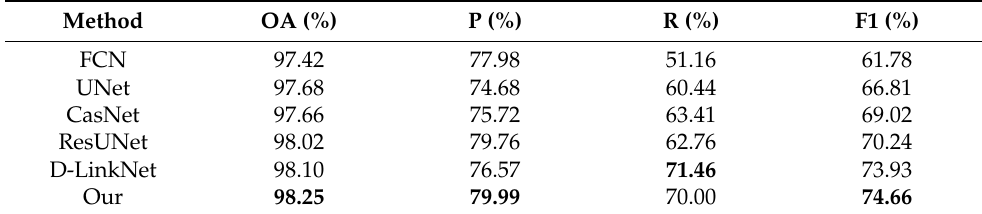
Table 1. Results of the comparative experiments on the DeepGlobe dataset.